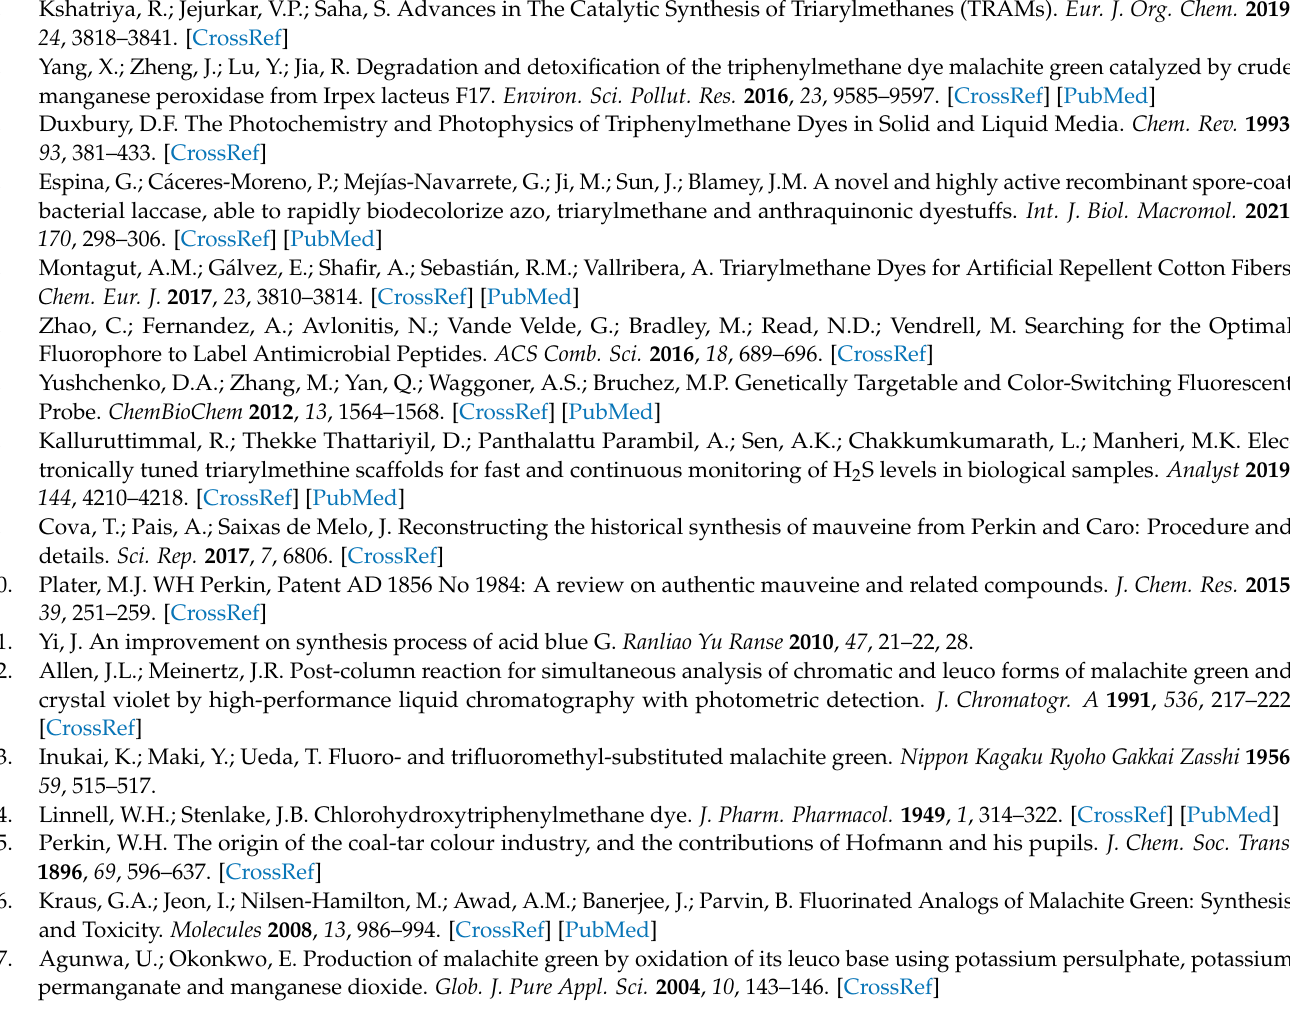
synthesized Acid Blue 7. Figure S5: HPLC results of 10 gram-scale synthesis; before purification (left) and after purification (right) by column